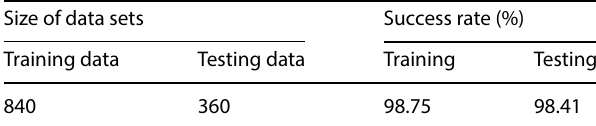
Table 10 Classification using PSO-based